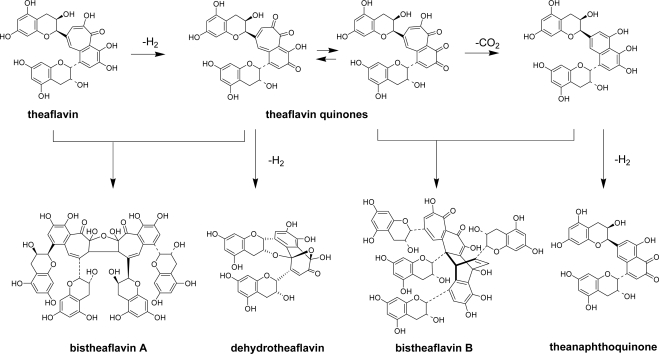
Oxidation of theaflavins [21–24].